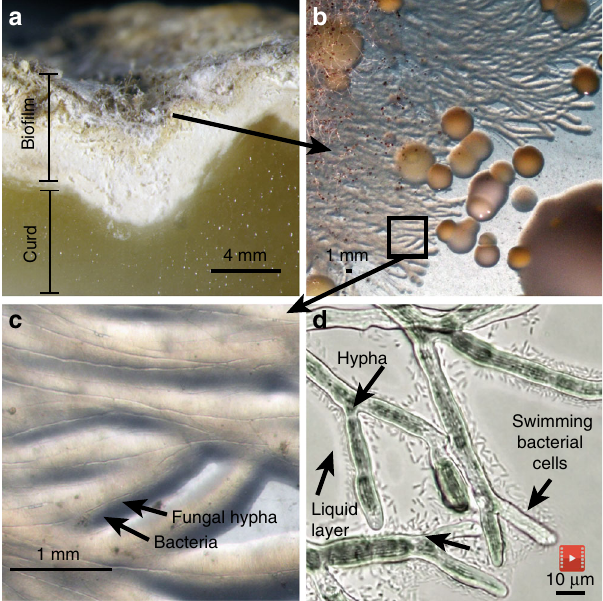
Fig. 1 Bacterial dispersal on fungal networks in a cheese rind. a Cross- section of the French cheese Saint-Nectaire, showing the curd (paste) and the bio fi lm (rind). b Unusual streams of bacteria were observed when plating out this rind on plate count agar with milk and salt (PCAMS). c Closer examination revealed the bacterium Serratia proteamaculans growing along the hyphae of the fungus Mucor lanceolatus . d Individual swimming Serratia cells in the liquid layer surrounding Mucor hyphae (still image